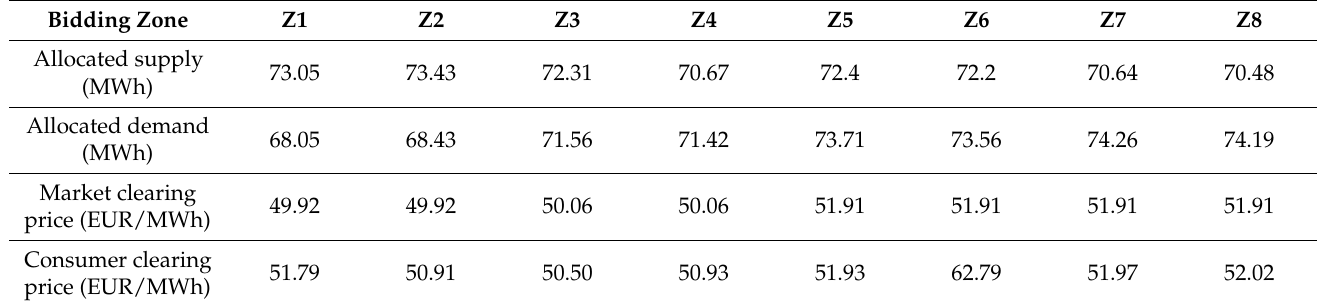
Table 5. Main clearing results of the third simulated scenario.